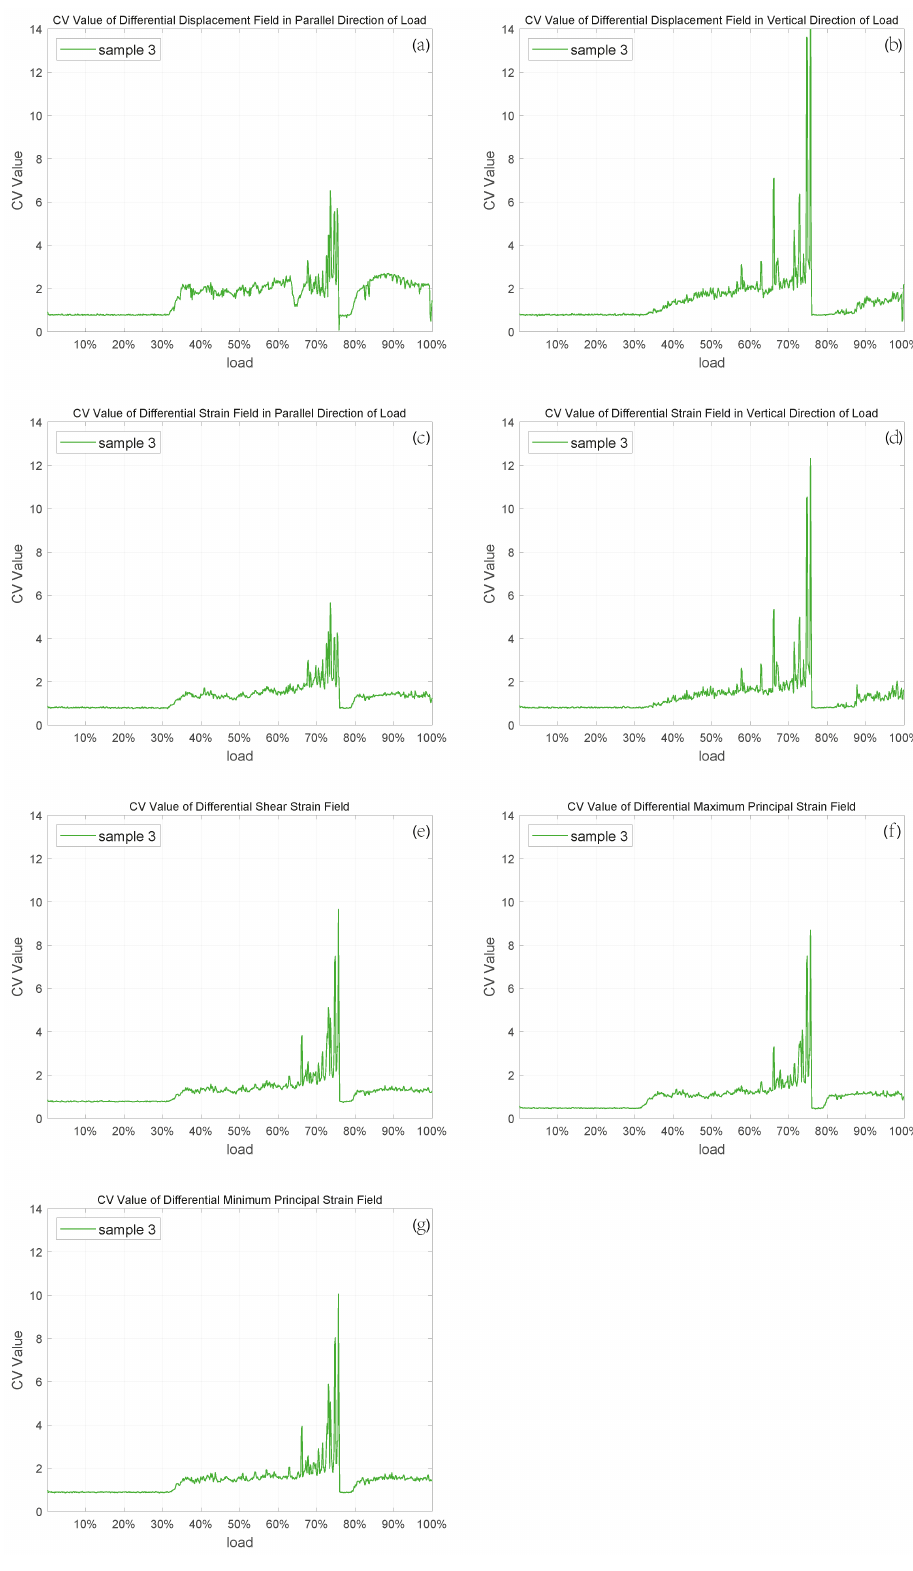
Figure A3. CV images of sample